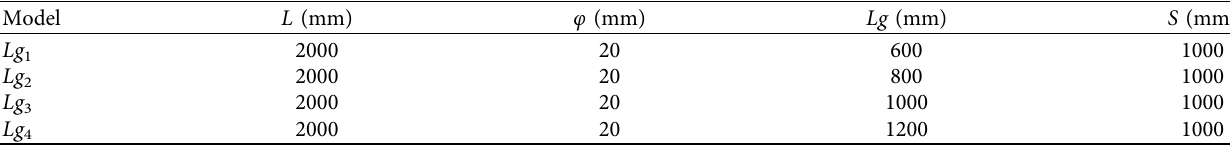
Table 10: Model design with different bolt spacings.